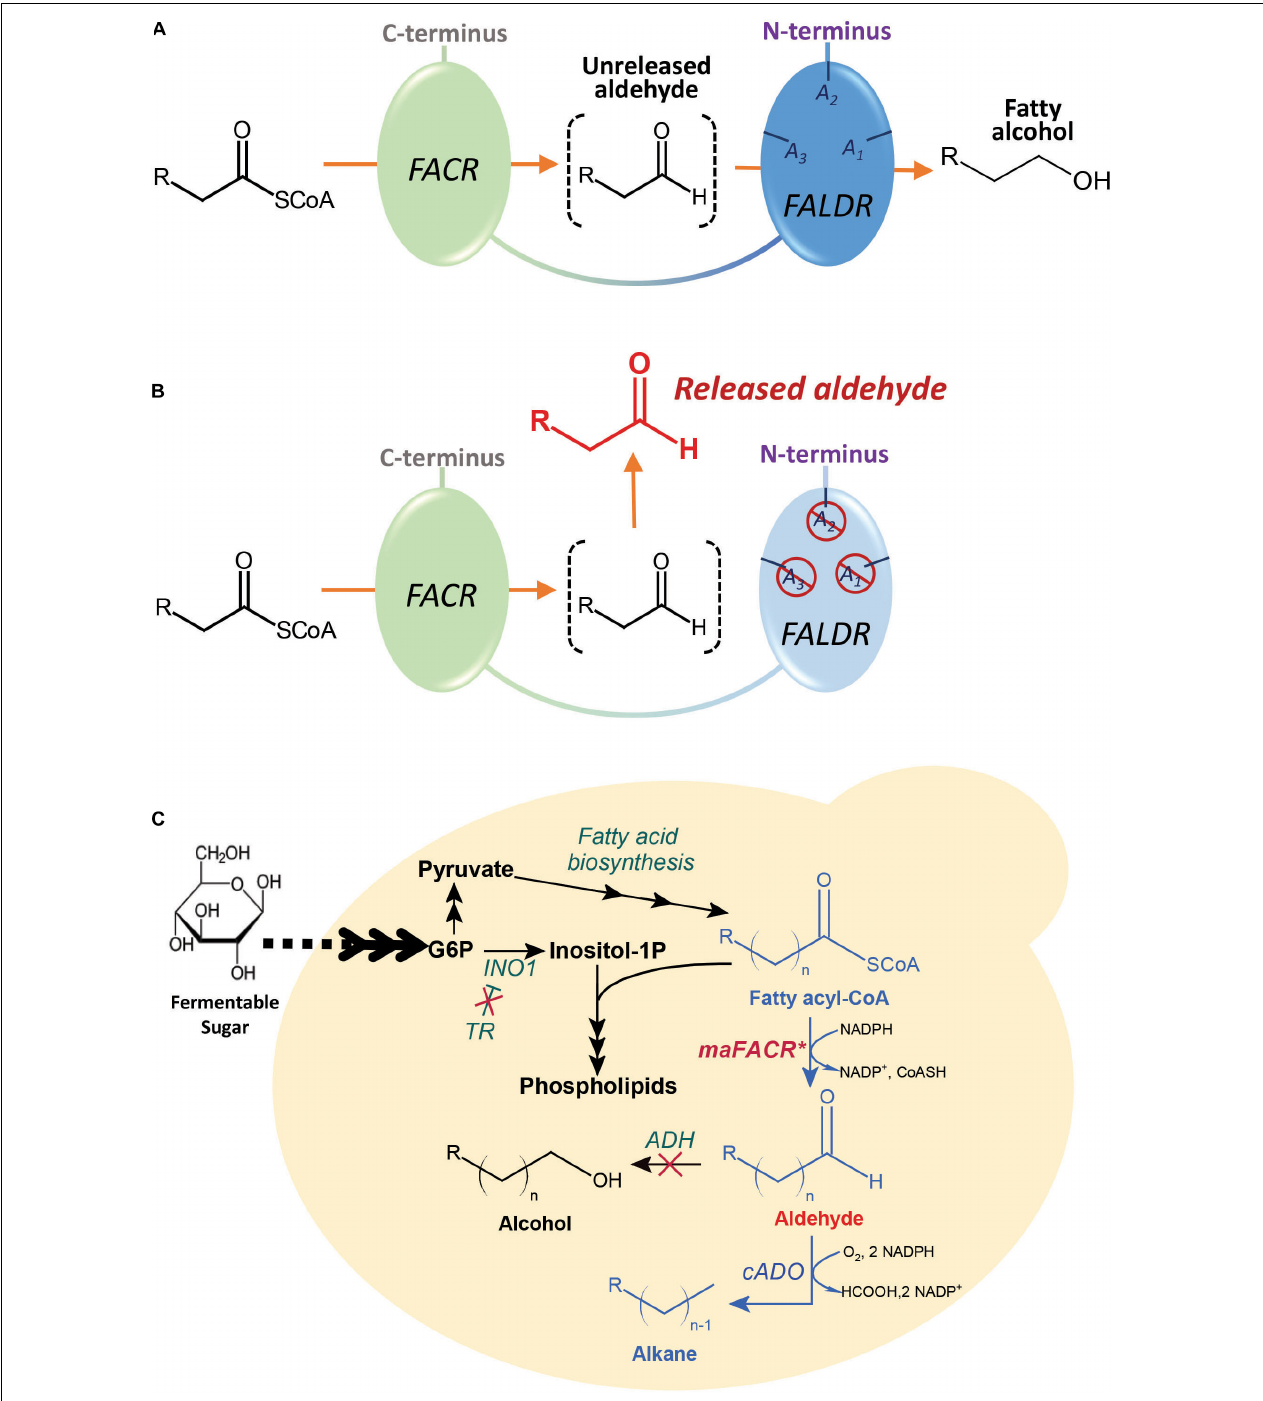
FIGURE 1 | Schematic illustration of the maFACR engineering strategy and metabolic pathway for the fatty acyl-CoA-dependent production of alkanes and alkenes (ALKs) in engineered Saccharomyces cerevisiae . (A) maFACR converts fatty acyl-CoA to alcohol without releasing the aldehyde intermediate. It putatively has two distinct domains: a fatty acyl-CoA reductase (FACR) domain for reducing fatty acyl-CoA to aldehyde and a fatty aldehyde reductase (FALDR) domain to reduce aldehyde to fatty alcohol. The FALDR domain has catalytic residues A1, A2, and A3, which are found in this work to be Ser126, Tyr152, and Lys156, respectively. (B) Mutating the FALDR catalytic residues A1, A2, and A3 with the S126D, Y152F, and K156A modifications, respectively, inactivates the domain, thus allowing the release of aldehyde from the enzyme. (C) The engineered aldehyde-forming maFACR* is employed for conversion of endogenous fatty acyl-CoAs to aldehydes in S. cerevisiae and subsequent production of ALKs by deformylation of the aldehydes with cADO. To improve aldehyde titer, a transcription regulator (TR) was deleted to increase fatty acyl-CoA production, and ADHs were inactivated to diminish reduction of aldehydes to alcohols. INO1 , inositol-3-phosphate synthase.